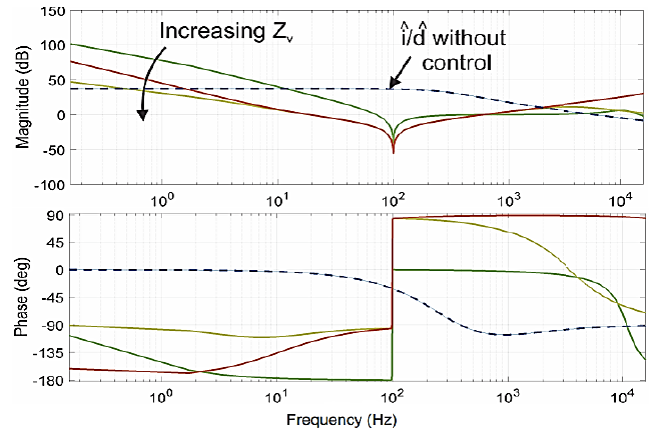
Figure 18. Variation of current control loop with respect to frequency.